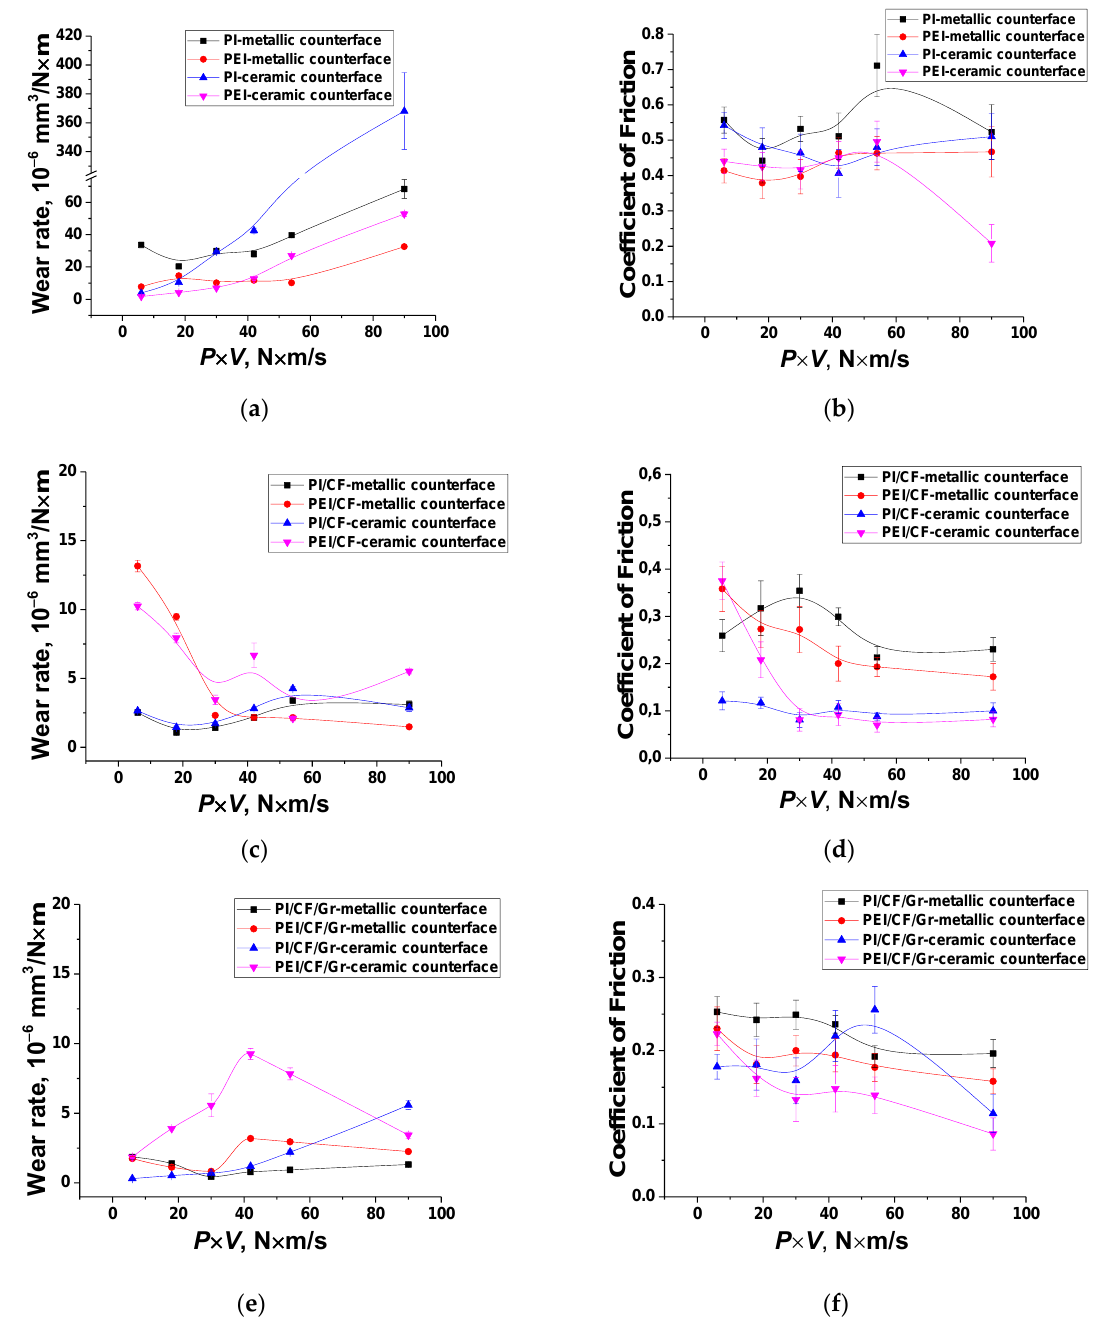
Figure 10. The dependence of the WR ( a , c , e ) and CoF ( b , d , f ) values from the P · V product for the